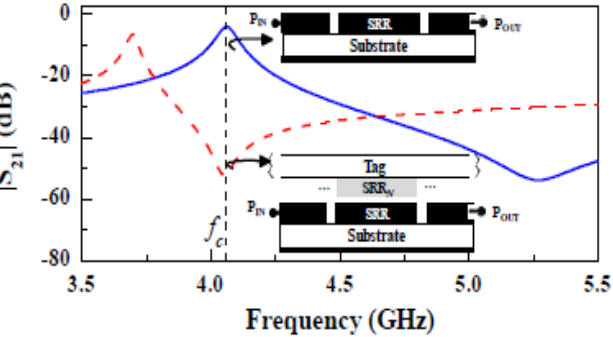
Figure 2. Simulated response of the reader without and with resonator on top of it. The considered substrate of the reader is Rogers RO3010 with dielectric constant ε r = 10.2, thickness h = 1.27 mm, and loss tangent tan δ = 0.0022. For the tag, the considered substrate is Rogers RO4003C with dielectric constant ε r = 3.55, thickness h = 0.20 mm, and loss tangent tan δ = 0.0021. SRR stands for split ring resonator. The air gap is considered to be 0.25 mm. Reprinted with permission from [59].